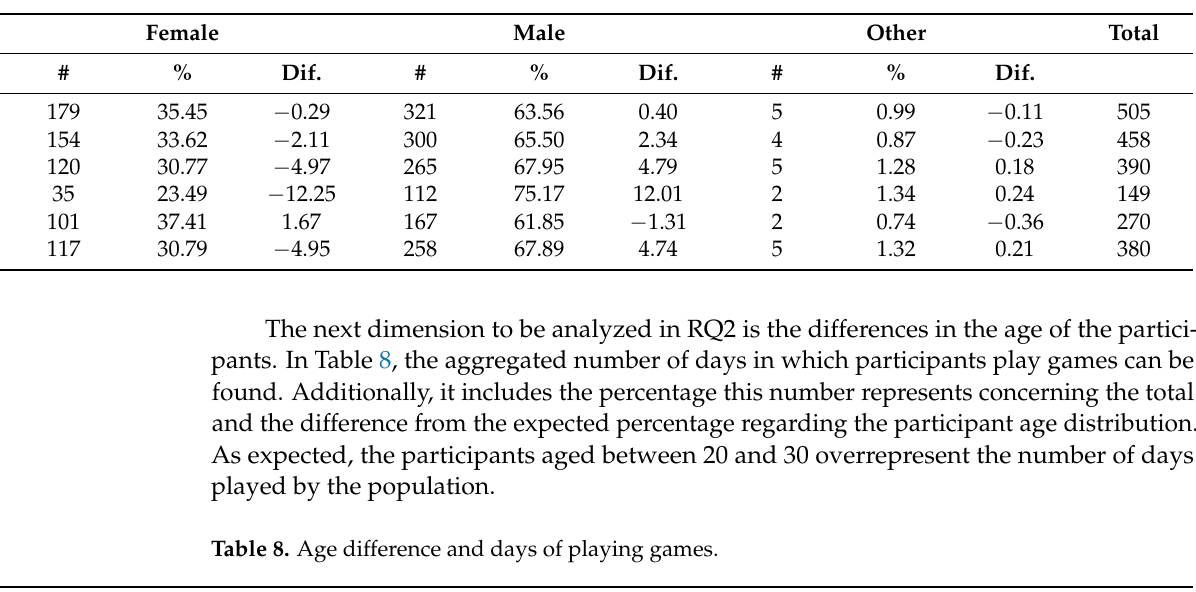
Table 7. Gender differences regarding game element preferences.